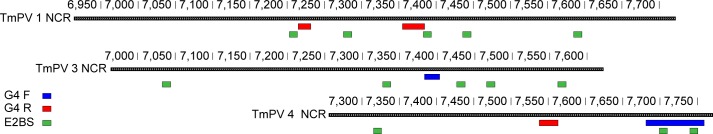
Location of G4 sequences in relation to putative E2 binding sites in the NCR region of each manatee papillomavirus.E2 binding sites are in green. G4 located on the forward DNA strand are in blue. G4 on the reverse DNA strand are in red.